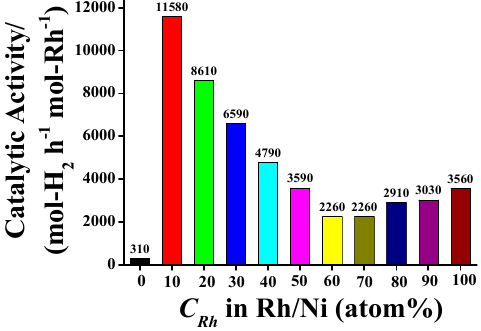
Figure 5. Comparison of catalytic activities of Rh (100–x) Ni x BNPs with Rh and Ni MNPs (x = 0, 10, 20, 30, 40, 50, 60, 70, 80, 90 and 100) and NPs ( R ISO = 40, C Metal = 0.66 mM, reduced under ice ‐ water bath for 1 h; pH = 12 for H 2 generation, 30 °C. The activities of Ni MNPs were normalized to mol ‐ H 2 ∙ h − 1 ∙ mol ‐ Ni − 1 ).